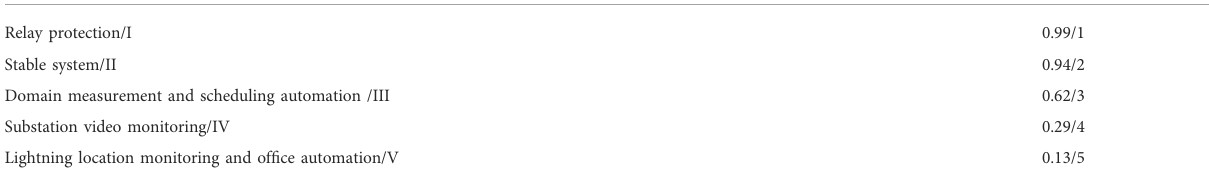
TABLE 2 Types and importance of electricity